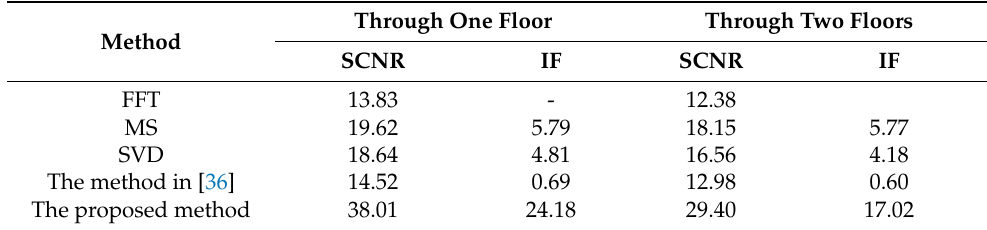
Table 4. Quantitative results of the through-floors